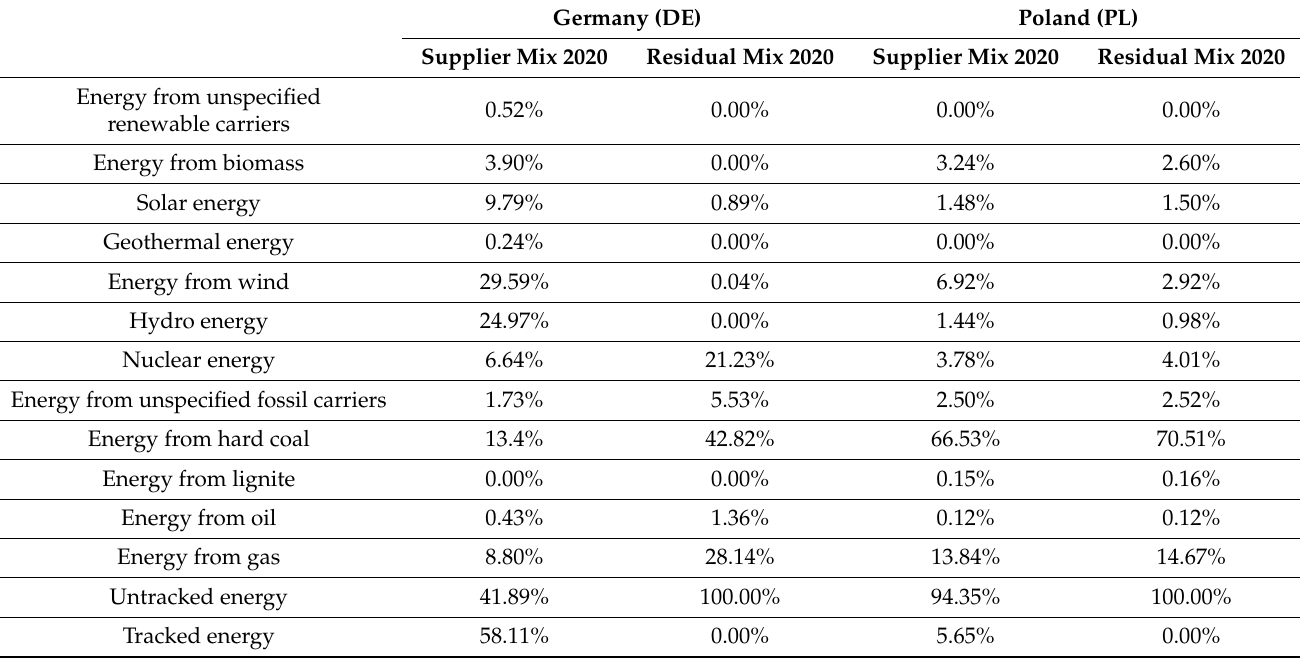
Table 2. Electricity residual mix and supplier mix for Poland and Germany in 2020 according to the Association of Issuing Bodies (AIB) [33].